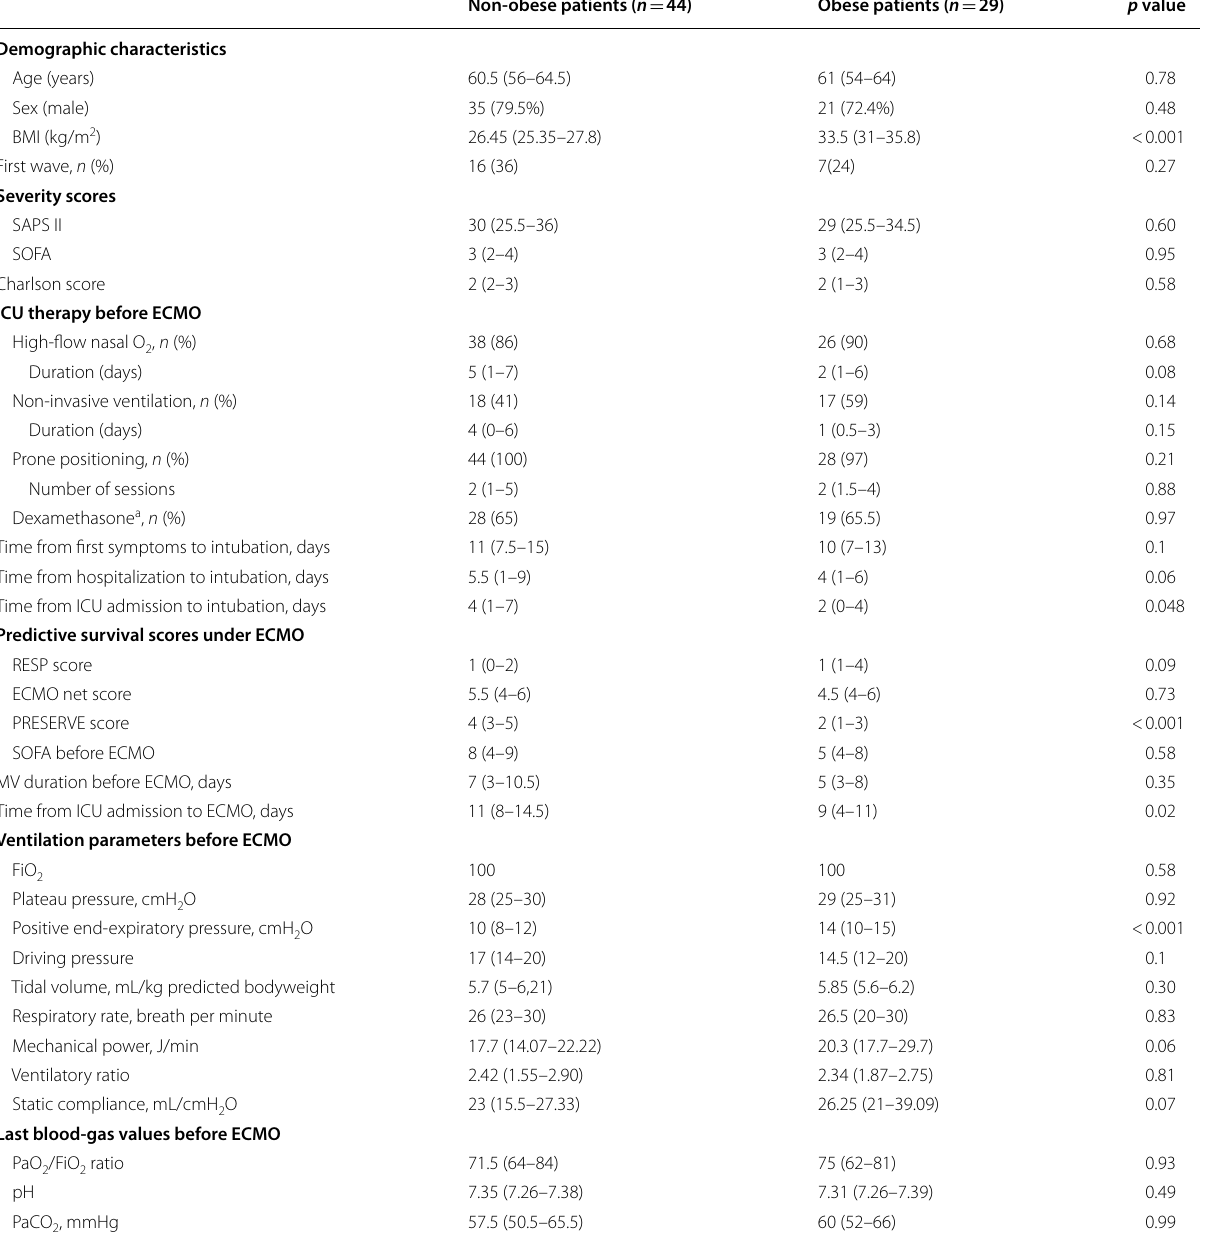
Table 4 Comparison of patient’s characteristics according to their obese status in univariate